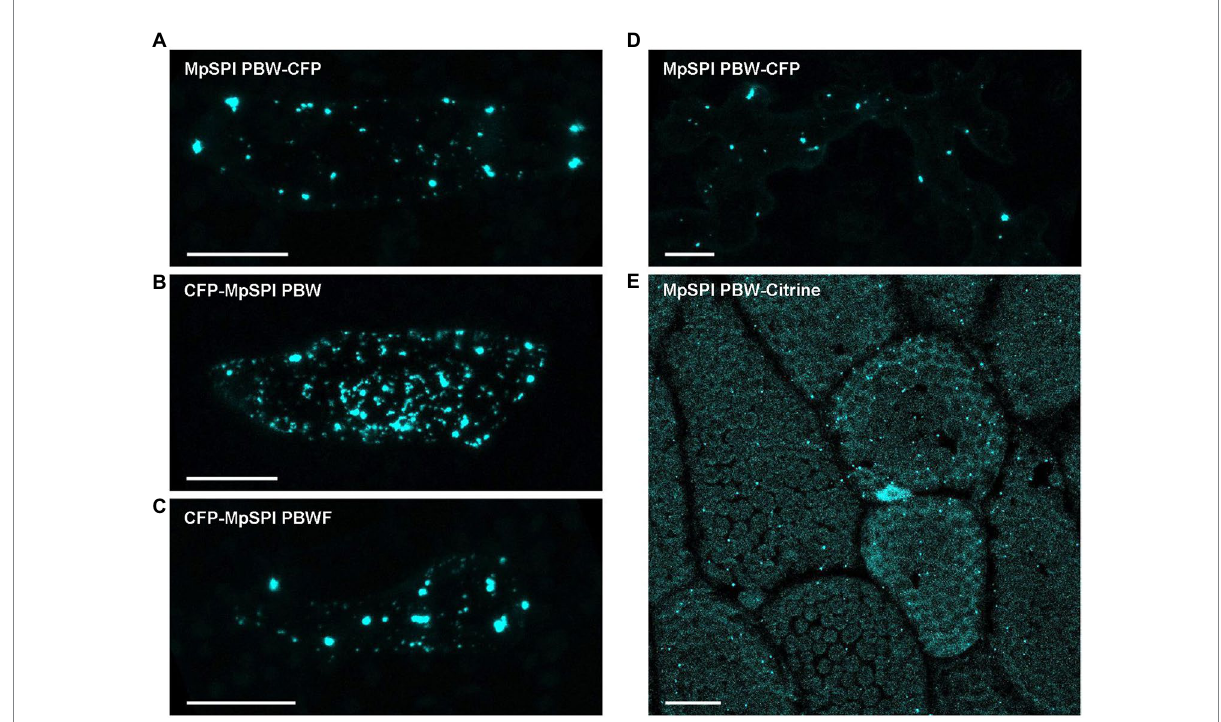
FIGURE 4 MpSPI PBW localizes to dot-like structures under non-stress conditions. (A) Transiently expressed, CFP tagged MpSPI PBW localizes to punctate structures in Tak-1 epidermal cells under normal conditions (B) irrespective of the position of the fluorescent tag and (C) the addition of the FYVE domain. Scale bars: 25 μ m. (D) Transiently expressed, CFP tagged MpSPI PBW localizes to punctate structures in A. thaliana Col-0 epidermal cells under normal conditions. Scale bar: 25 μ m. (E) Citrine tagged MpSPI PBW was stably transformed into regenerating Tak-1 thalli. Image shows a 5-day-old gemmae derived from the stable line. Scale bar: 25 μ